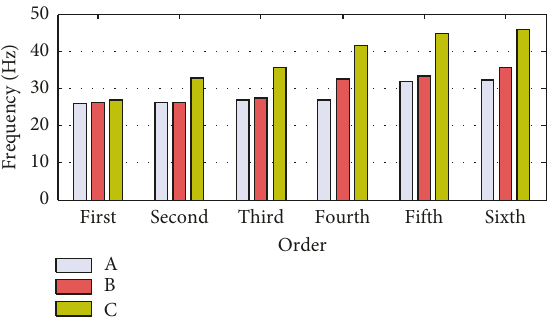
Figure 8: Comparison of the first six natural frequencies of the inlet pipeline modification models.